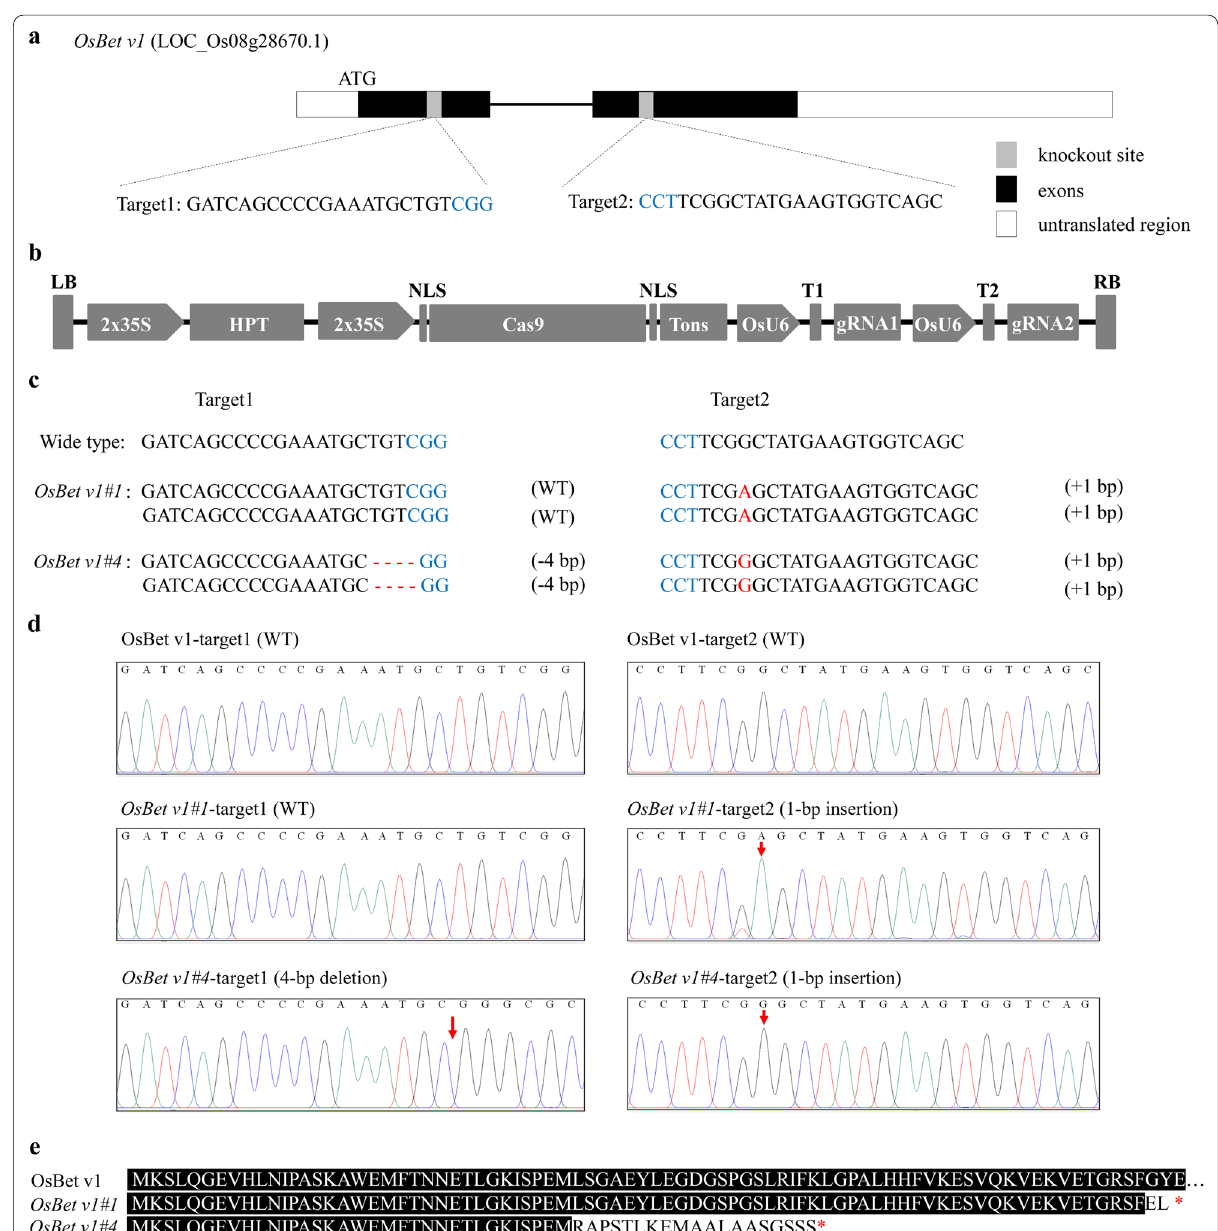
Fig. 4 CRISPR/Cas9-targeted mutagenesis of OsBet v1 . a Two target sites of CRISPR/Cas9 in exons. b Diagram of the binary vector pYLC-OsBet v1. c The mutation sequences of OsBet v1 knockout rice lines. The number of base deletion and/or insertion is shown by the mark of minus ( ( ) followed by a number in brackets, respectively. Nucleotides in blue represent PAM sequences. Red letters and red hyphens denote insertions + and deletions, respectively. d Sequence peaks of the wild-type (WT) and mutation types at target sites. The red arrowheads indicate the location of mutations. e Alignments of the deduced amino acid sequence of OsBet v1 from OsBet v1 knockout rice lines and WT. Asterisks indicate the termination of